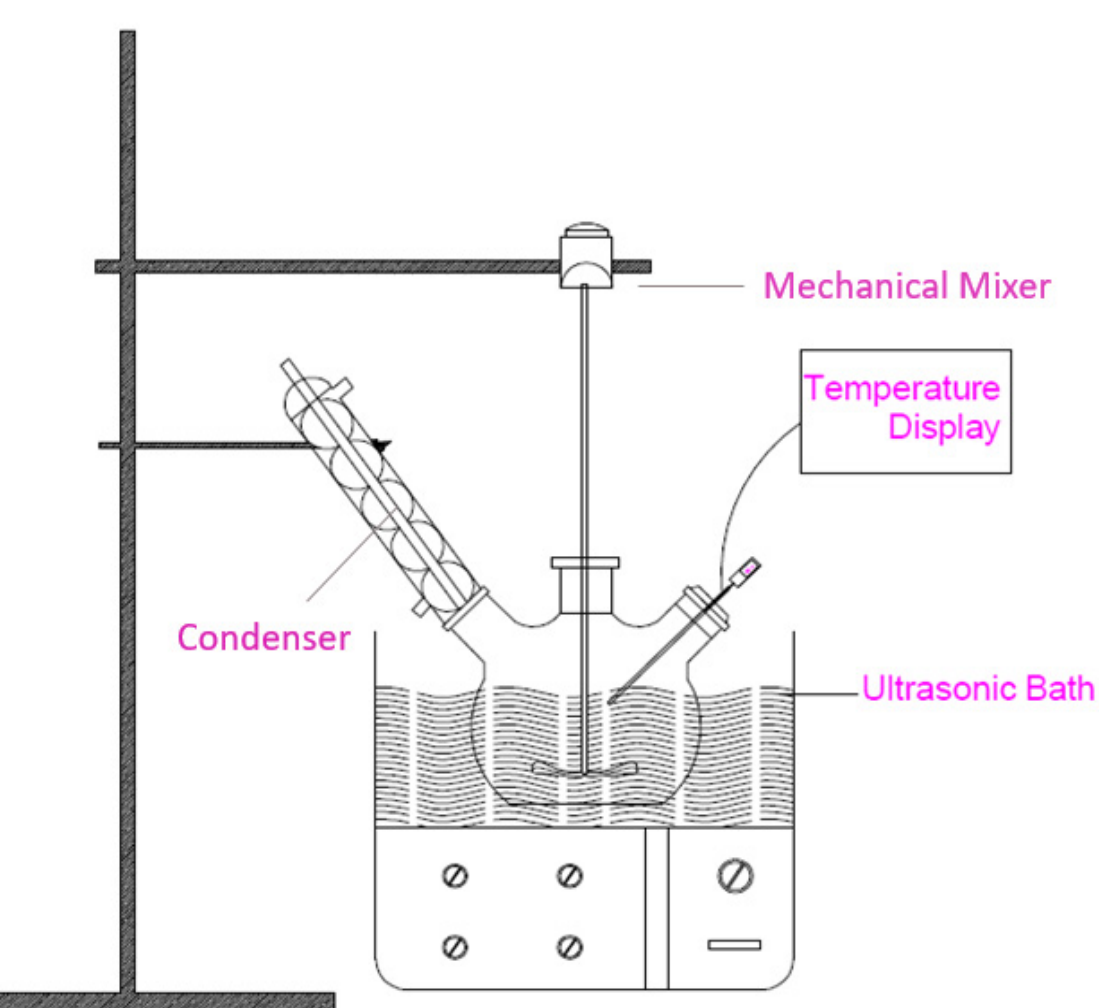
Figure 1. Schematic of experimental setup.